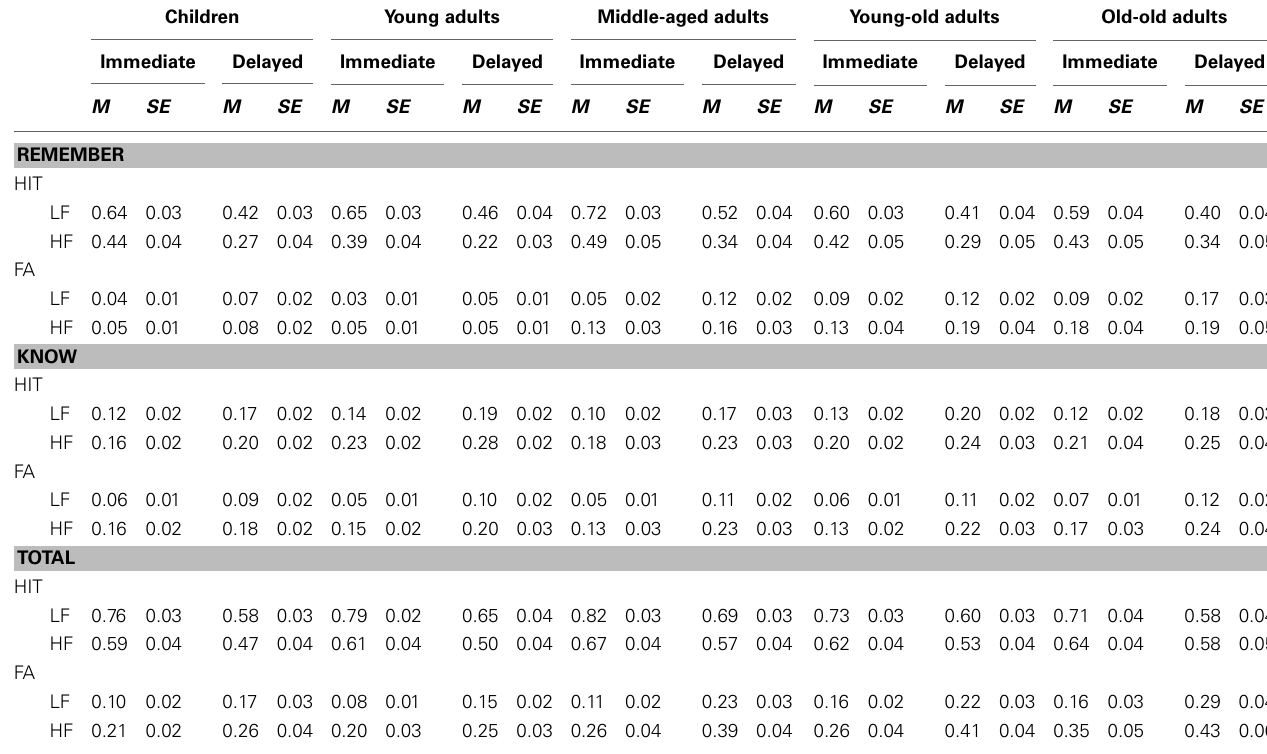
Table 3 | Experiment 2: Means and standard errors of hits and false alarm